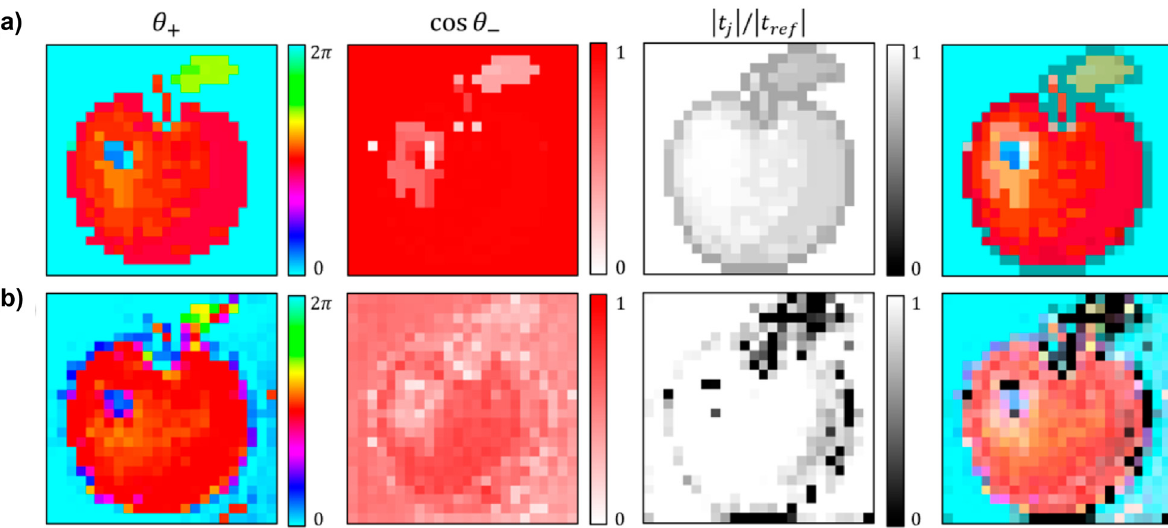
Figure 5: 3 degrees of freedom Jones matrix coincidence imaging. (a) The Jones matrix image (right-most image) is obtained by mapping the 3 image profiles in 𝜃 + , cos 𝜃 − , brightness as third column as visualization of the Jones matrix elements). (b) The retrieved Jones matrix image profiles of an unknown object. The retrieved profiles in 𝜃 + , cos 𝜃 − , Figure 4), which is then used to reconstruct the object’s Jones matrix